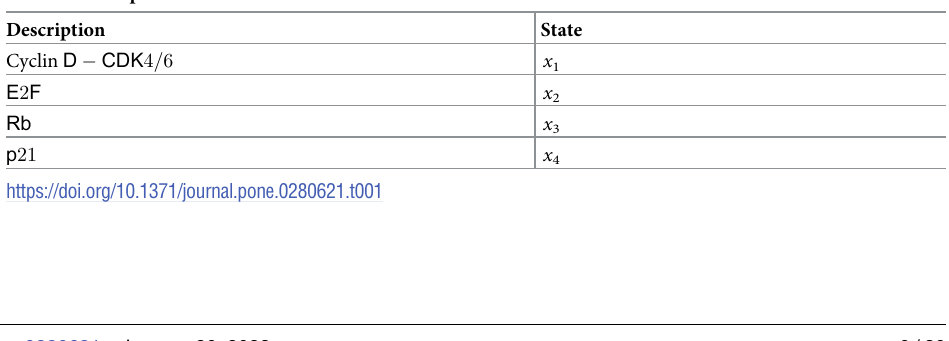
Table 1. Description of the cell states at the